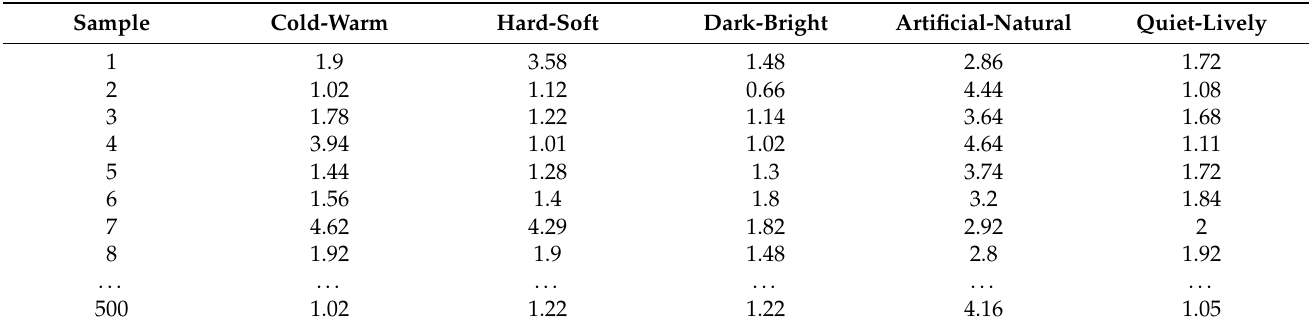
Table 3. Data table of ceramic color semantic quantification samples.